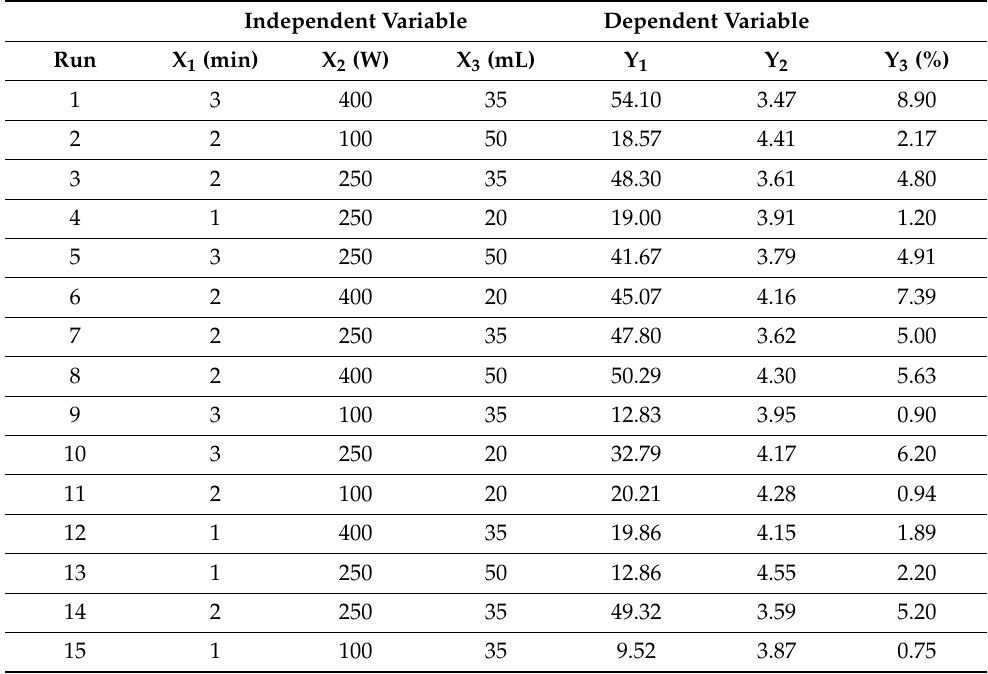
Table 2. Experimental matrix and observed responses for PET pretreatment in